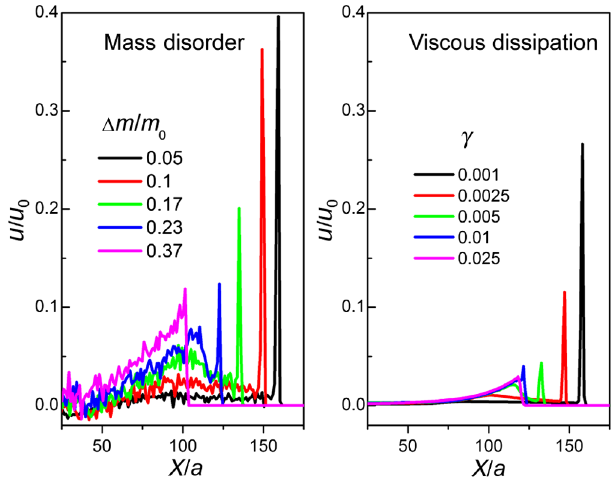
FIG. 4. Effects of disorder (left panel) and dissipation (right panel) on the nonlinear waves of granular packings. The curves are the snapshots of the longitudinal velocity field normalized by the speed of initial impact u 0 , taken at the same instant of time for packings with different mass disorders (left) and different coefficients of viscous dissipation γ (right). For low disorder and dissipation, the pulses are weakly attenuated, and since the speed of the pulse depends upon its amplitude, they travel further into the packing. Comparing the two panels, we see the somewhat analogous effects of disorder and